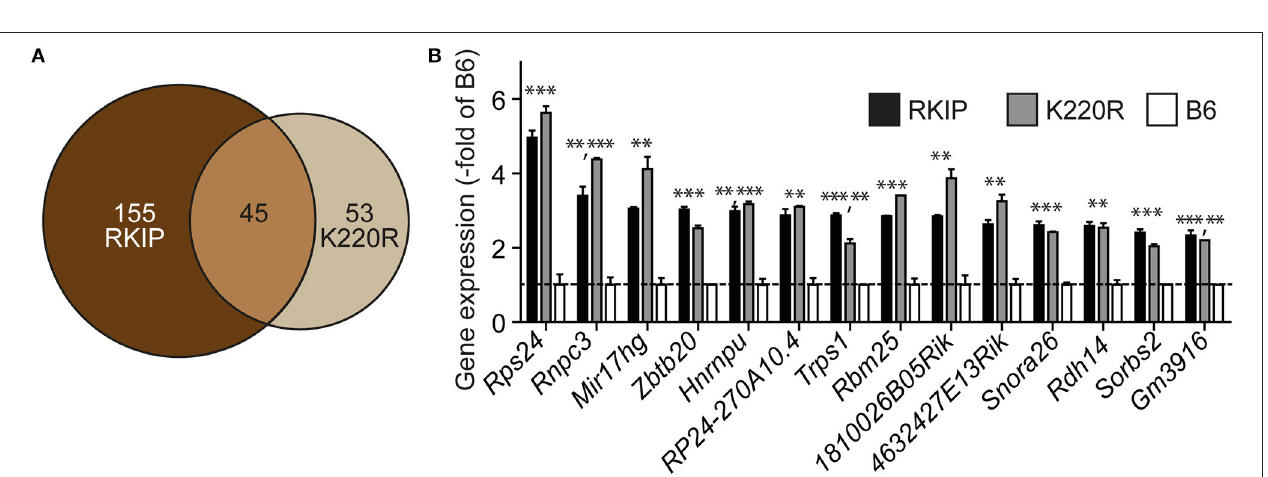
FIGURE 10 | Concordant gene regulation in Tg-RKIP and Tg-GRK2K220R hearts. (A,B) Whole genome microarray gene expression profiling was performed with 8-months-old Tg-RKIP2 and Tg-GRK2-K220R hearts compared to non-transgenic B6 hearts. Probe sets with significantly different signal intensity (with call present and/or signal intensity > 100) were identified with p < 0.01, and ≥ 2-fold difference compared to B6. The Venn diagram illustrates the number of concordantly regulated genes between Tg-RKIP and Tg-GRK2K220R hearts (A) . Representative probe sets (B) show comparable up-regulation of concordantly regulated genes in Tg-RKIP and Tg-GRK2K220R hearts ( ± s.d.; n = 2 gene chips/group with n = 3 hearts pooled for one gene chip; *** p < 0.001, ** p < 0.01 vs. B6; Dunnett’s